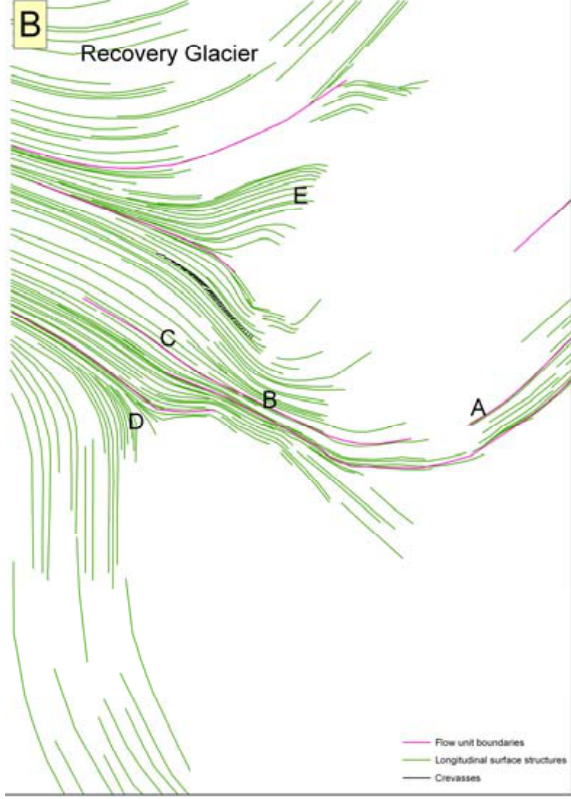
Fig. 5a. Portion of Landsat image from LIMA showing tributary glacier to Recovery Glacier as it enters the Filchner Ice Shelf. Figure 5A. Portion of Landsat Figure 5A. Portion of Landsat image from LIMA showing tributary image from LIMA showing tributary glacier to Recovery Glacier as it glacier to Recovery Glacier as it enters the Filchner Ice Shelf enters the Filchner Ice Shelf